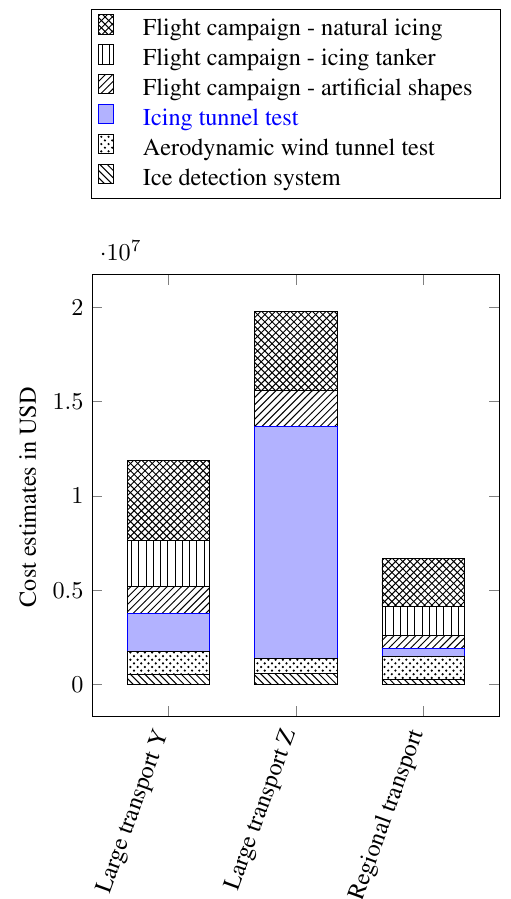
Figure 2. Cost estimation for aircraft icing certification according to FAR Part 25 Appendix O, based on the working group report on supercooled large droplet rule-making IPHWG